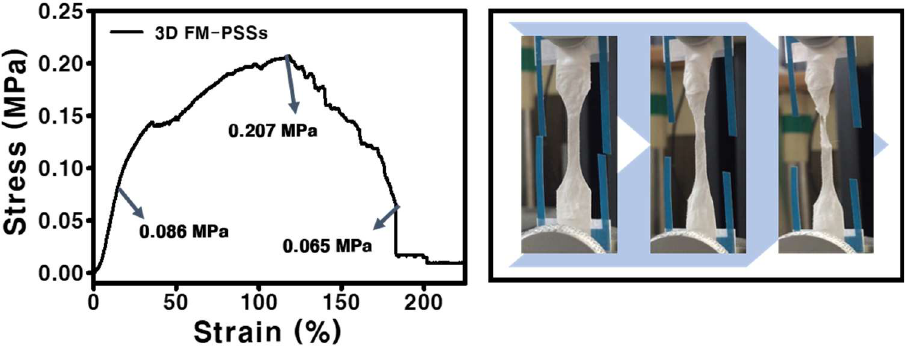
Figure 4. Strain-stress curve and the digital image of 3D FM-PSSs.